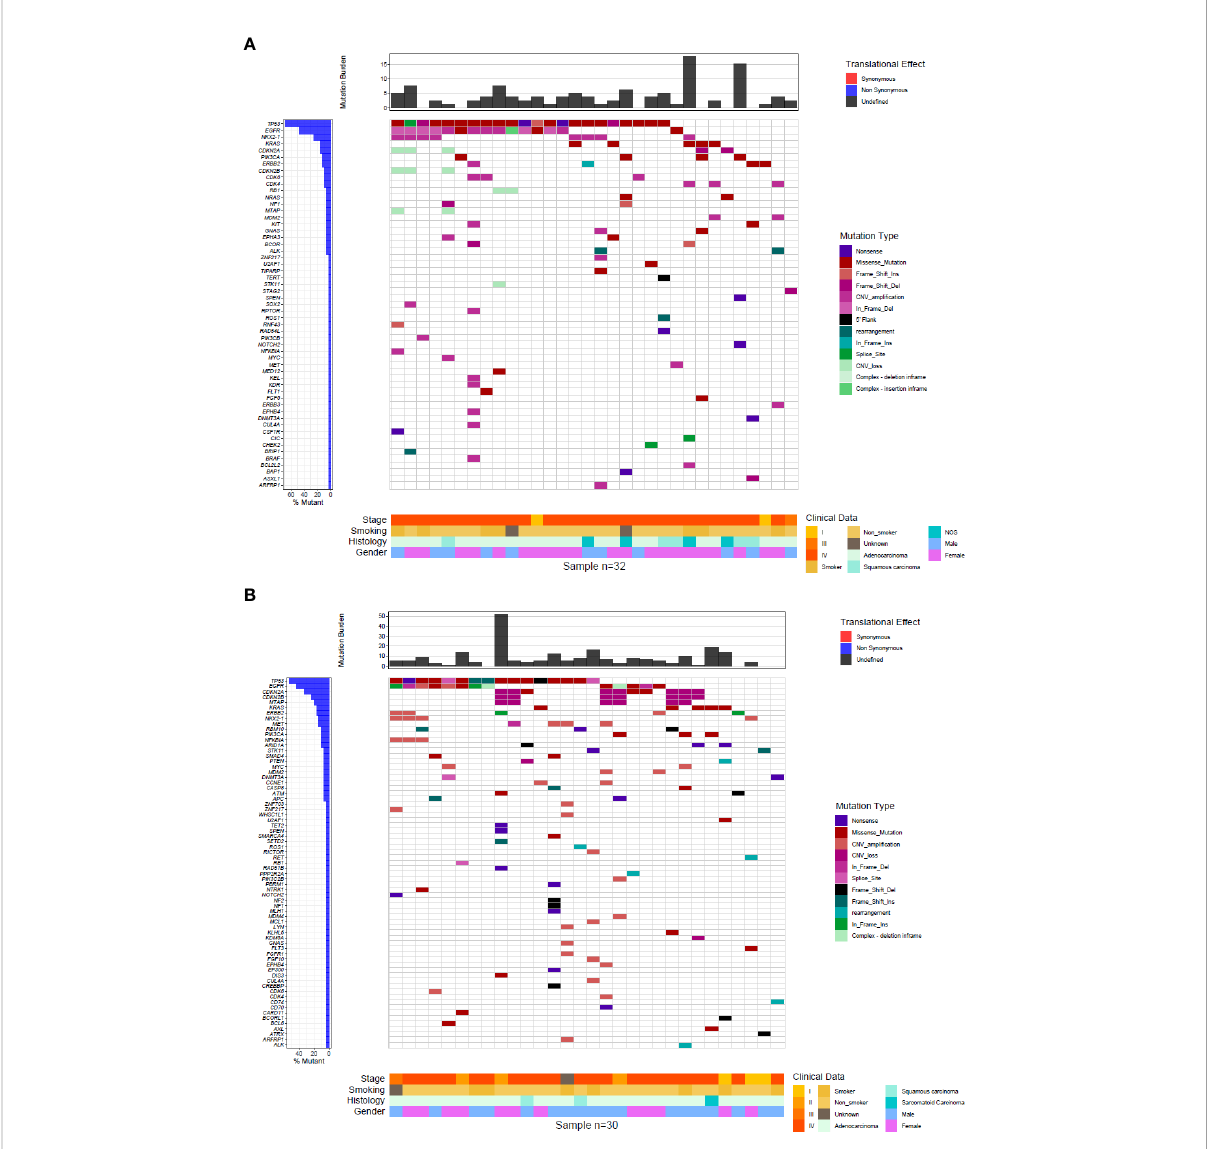
FIGURE 2 Comprehensive visualization of the genomic landscape of NSCLC. (A) young (B) older